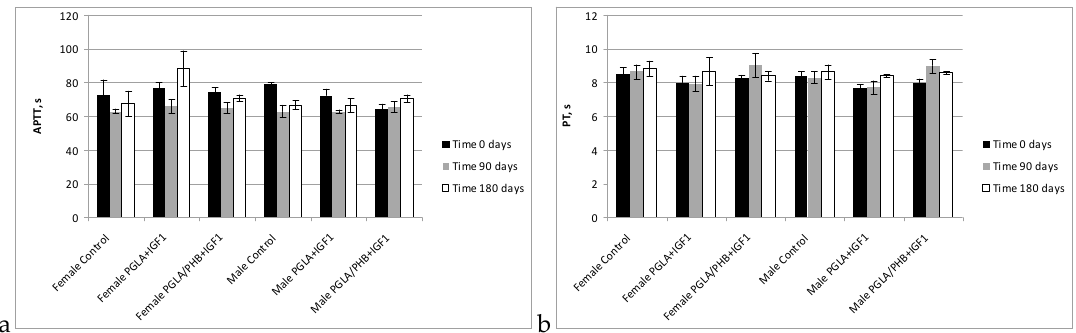
Figure 9. Activated partial thromboplastin time (APTT) ( a ) and prothrombin time (PT) ( b ) of blood of rabbits.